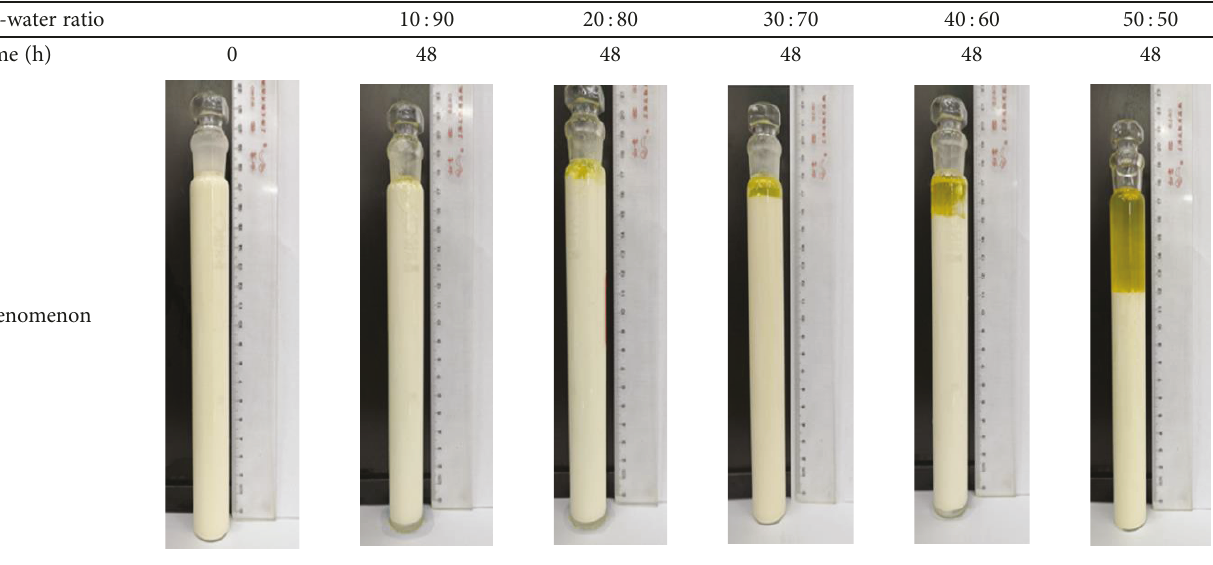
Table 2: The evaluation of sedimentation stability.